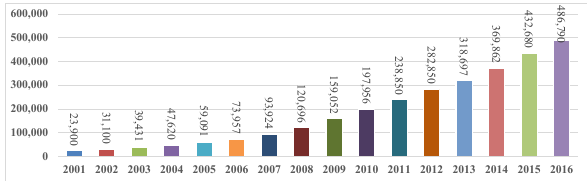
Figure 1: Global Cumulative Installed Wind Capacity 2001-2016 in MW [7].